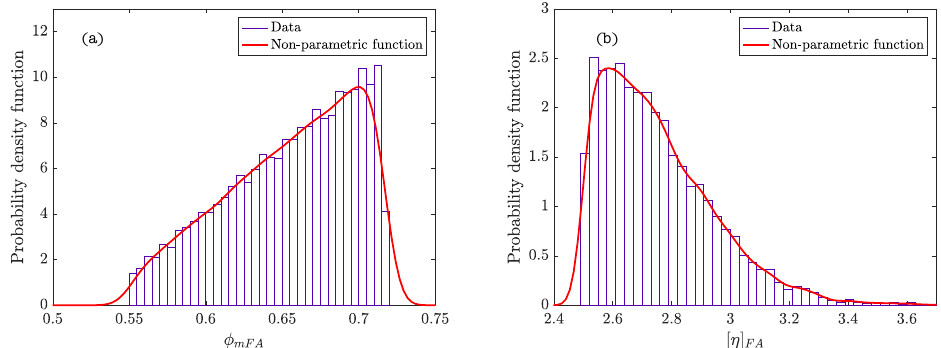
Figure 8. Probability density functions of the parameters of the fine granular phase (FA) in self- compacting mortar: ( a ) φ mFA ; ( b ) [ η ] FA